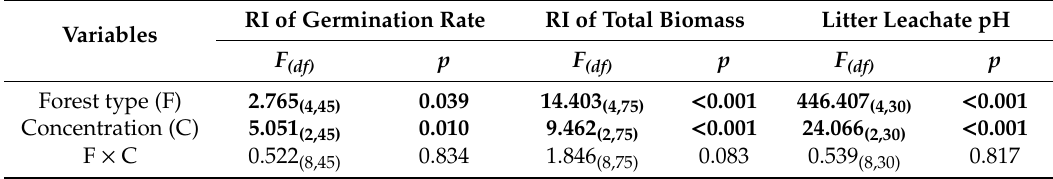
Table A2. The e ff ects of the forest type, litter leachate concentration (0.1 g / mL, 0.05 g / mL or 0.025 g / mL), and their interactions on the RI of the germination rate, RI of the total biomass of Phytolacca americana and litter leachate pH, based on two-way ANOVA. Degrees of freedom are indicated as subscripted numbers in parentheses after the F-value. Statistically significant values ( p < 0.05) are denoted by bold